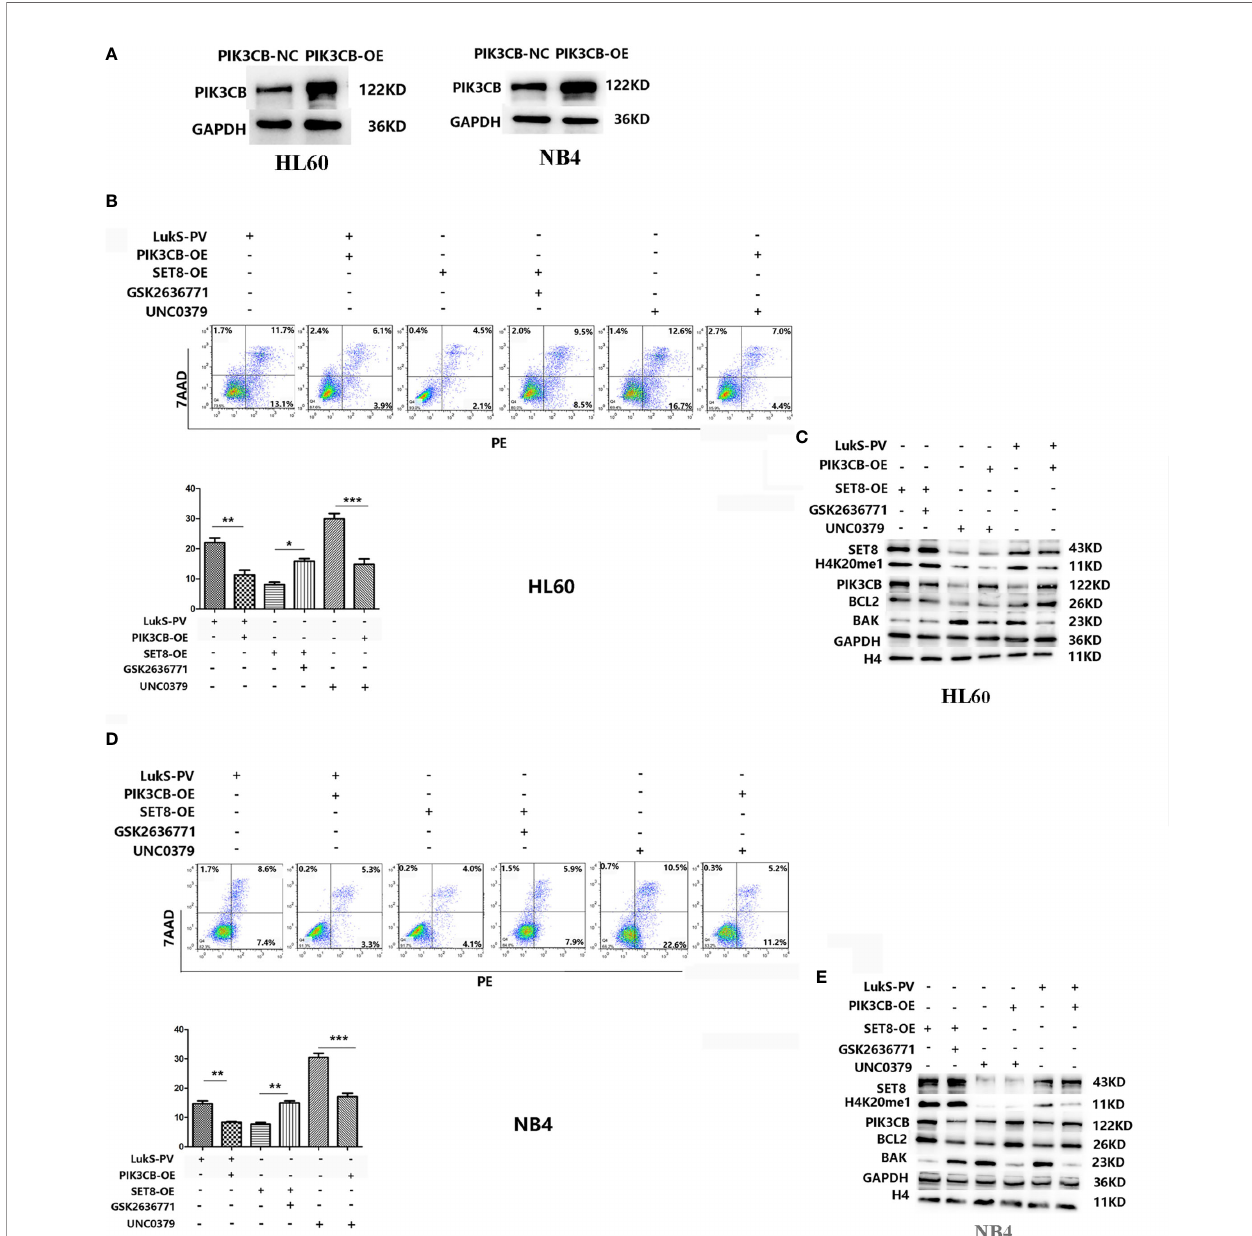
FIGURE 6 | LukS-PV induces apoptosis in acute myeloid leukemia (AML) cells by downregulating PIK3CB via SET8/H4K20me1. (A) PIK3CB overexpression in HL- 60 (left) and NB4 (right) cells. (B) Apoptosis was determined in HL-60 cells via fl ow cytometry. (C) Apoptosis-related proteins were determined by Western blotting in HL-60 cells. (D) Apoptosis was determined in NB4 cells via fl ow cytometry. (E) Apoptosis-related proteins were determined by Western blotting in NB4 cells. ns, not signi fi cant; *p < 0.05; **p < 0.01; ***p <